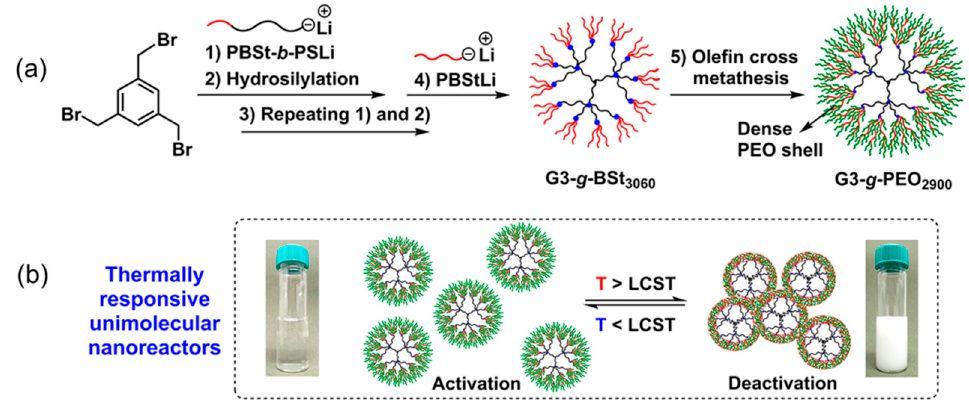
Figure 51. ( a ) Five-step process for synthesis of poly(styrene) interior, PEO exterior unimolecular micelle reactor. ( b ) Thermally responsive unimolecular reactors exhibiting low critical solution temperature (LCST) properties due to PEO periphery. Reprinted with permission from [196]. Copyright 2019 American Chemical Society.